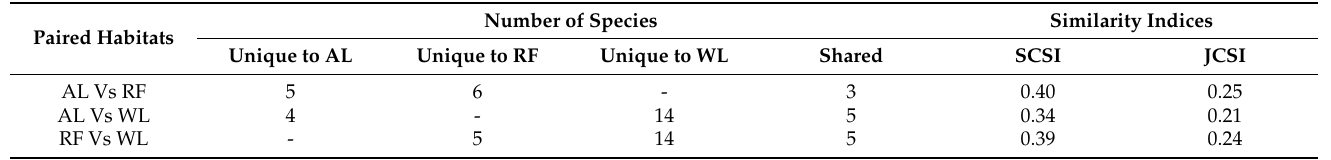
Table 4. Sorensen’s Coefficient Similarity Index (SCSI) and Jaccard’s Coefficient Similarity Index (JCSI) of frog species among the three habitat